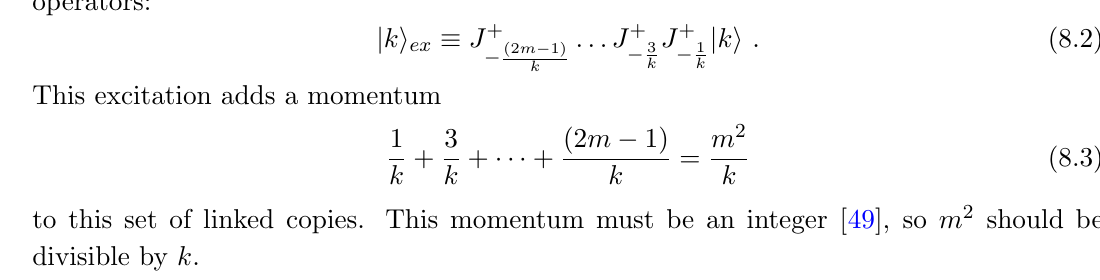
Figure 6 . A total of N singly wound copies that have been linked into N each of winding k . A number n of these twisted sets have been excited by current operators.